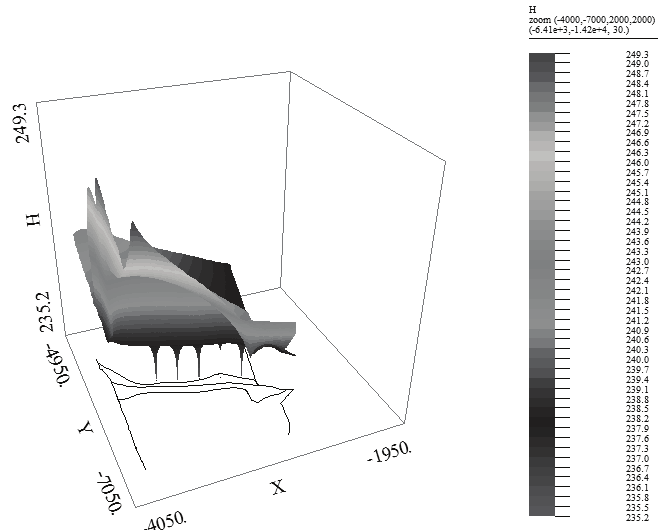
Fig. 12. Spatial map of water table height in the area of water collection point for Kamieniec Ząbkowicki, generated for the water level in the reservoir of 255.50